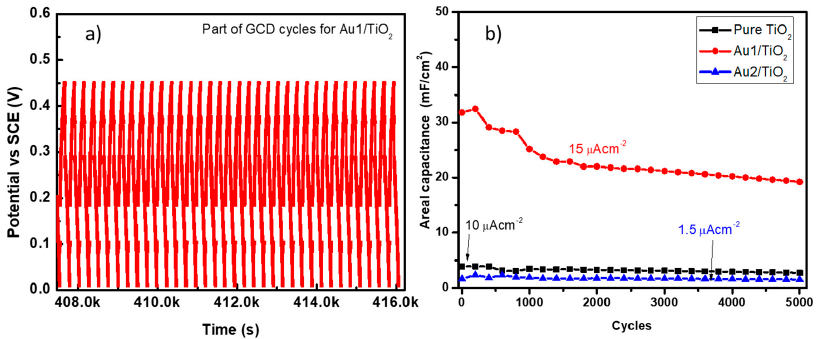
Figure 11. ( a ) Part of the cycles of the GCD curve of Au1/TiO 2 and ( b ) the cyclic stability for pure TiO 2 , Au1/TiO 2 , and Au2/TiO 2 electrodes. Table 1. Comparison with similar thin-film electrodes, in terms of the type, selfstanding, and areal capacitance.